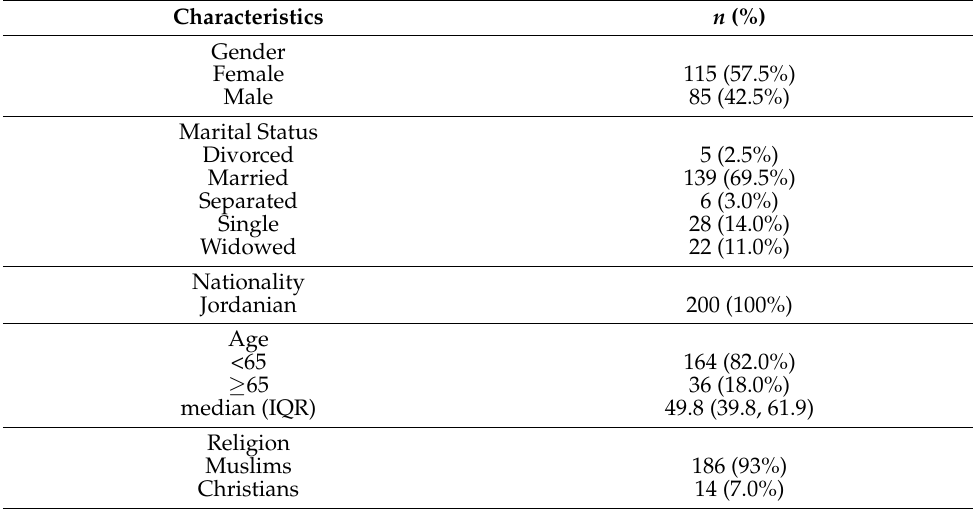
Table 1. Patient demographics and clinical characteristics ( n =